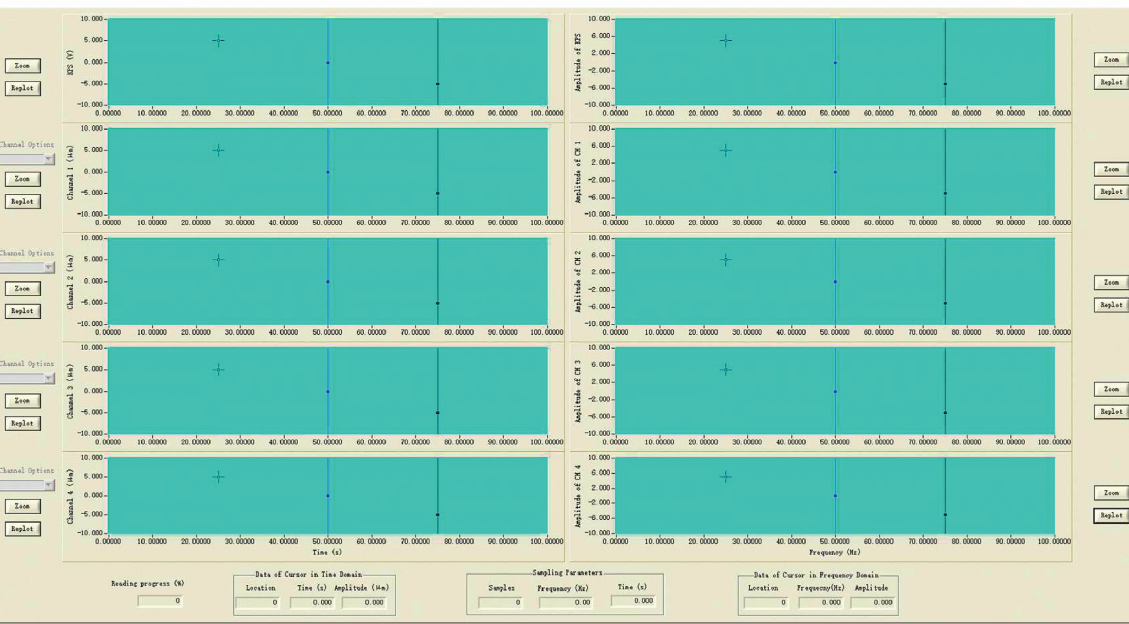
Figure 9: The playback interface of recording